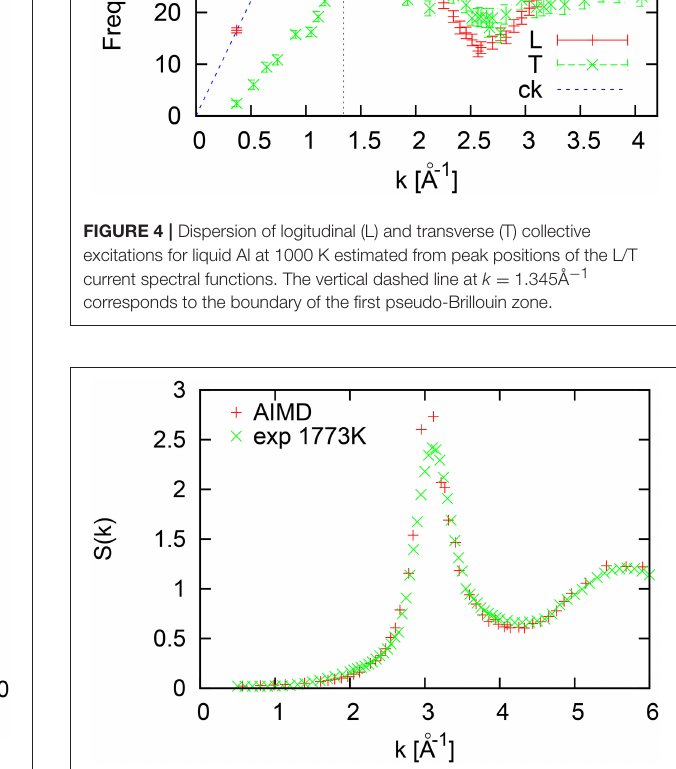
300 for Tl was used in the simulations, and only the Ŵ -point was